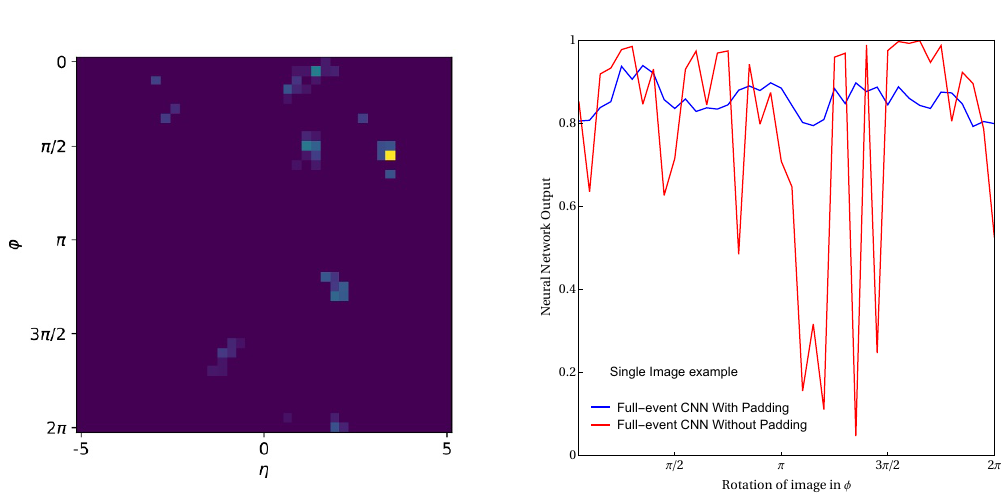
Figure 9 . Left: a typical signal event image. Right: the output of the neural network on the left image, after rotation in the (cid:30) direction by the given number of